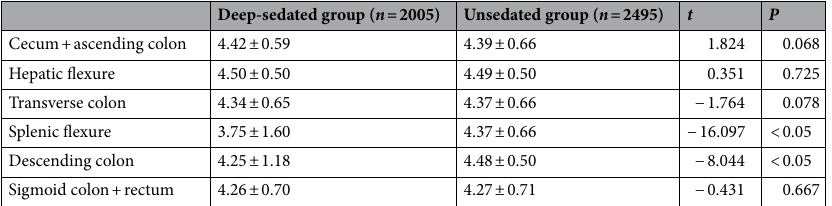
Table 3. Comparison of luminal distention scores between deep-sedated group and unsedated group.